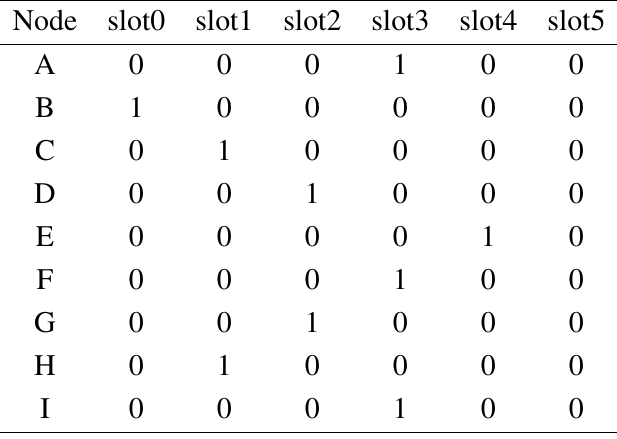
Table 4. Slot schedule with SERENA two-hop